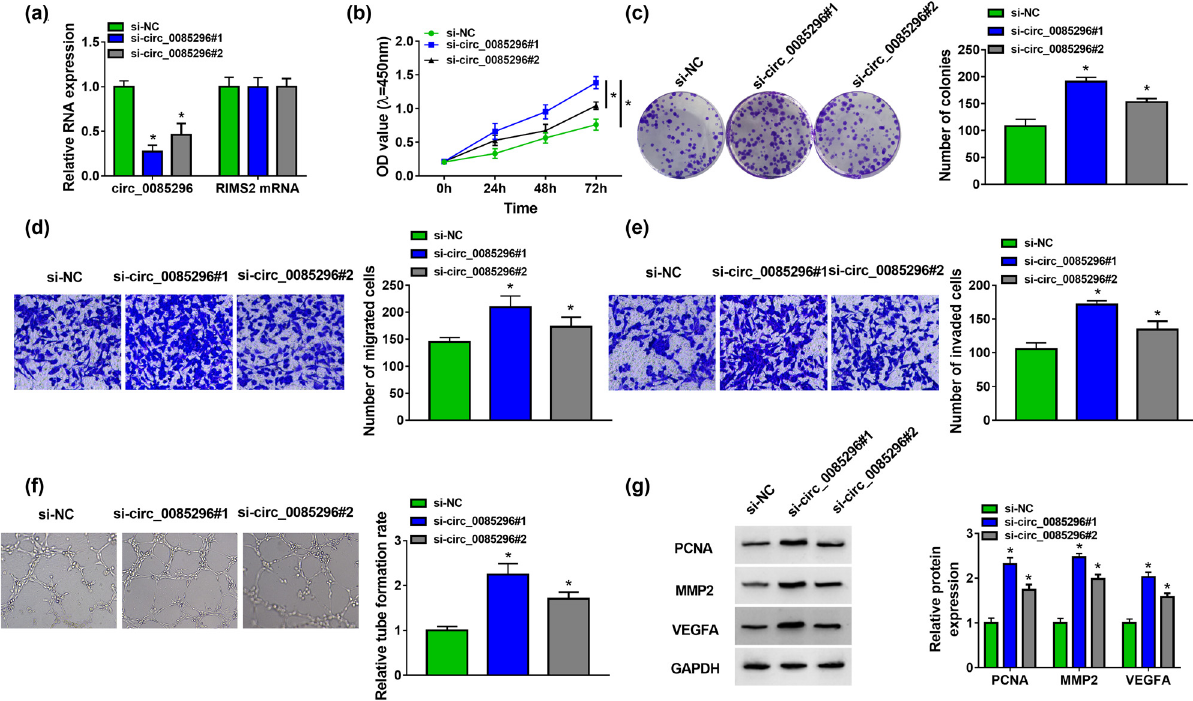
Figure 2: E ff ects of circ_0085296 knockdown on the biological functions of HTR8/SVneo cells. HTR - 8/SVneo cells were transfected with si - NC or si - circ_0085296#1/#2. ( a ) The expression of circ_0085296 and RIMS2 was detected by qRT - PCR. CCK8 assay ( b ) , colony formation assay ( c ) , Transwell assay ( d and e ) , and tube formation assay ( f ) were performed to measure cell proliferation, migration, invasion, and angiogenesis, respectively. ( g ) The protein levels of PCNA, MMP2, and VEGFA were tested by WB analysis. * P <